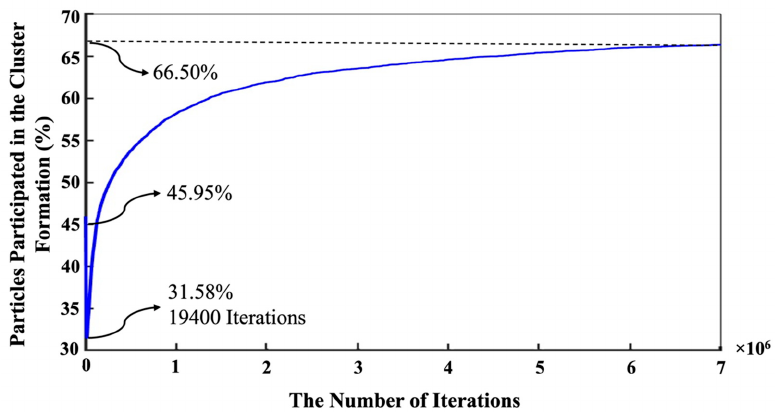
Figure 11. Number evolution of particles in the cluster formation during 7 million iterations. The equilibrium condition for the cluster formation was obtained as a percentage of 66.35 after 7 million iterations. Metakaolinite particles were considered as monomers at the beginning of the simulation (at zero iteration).